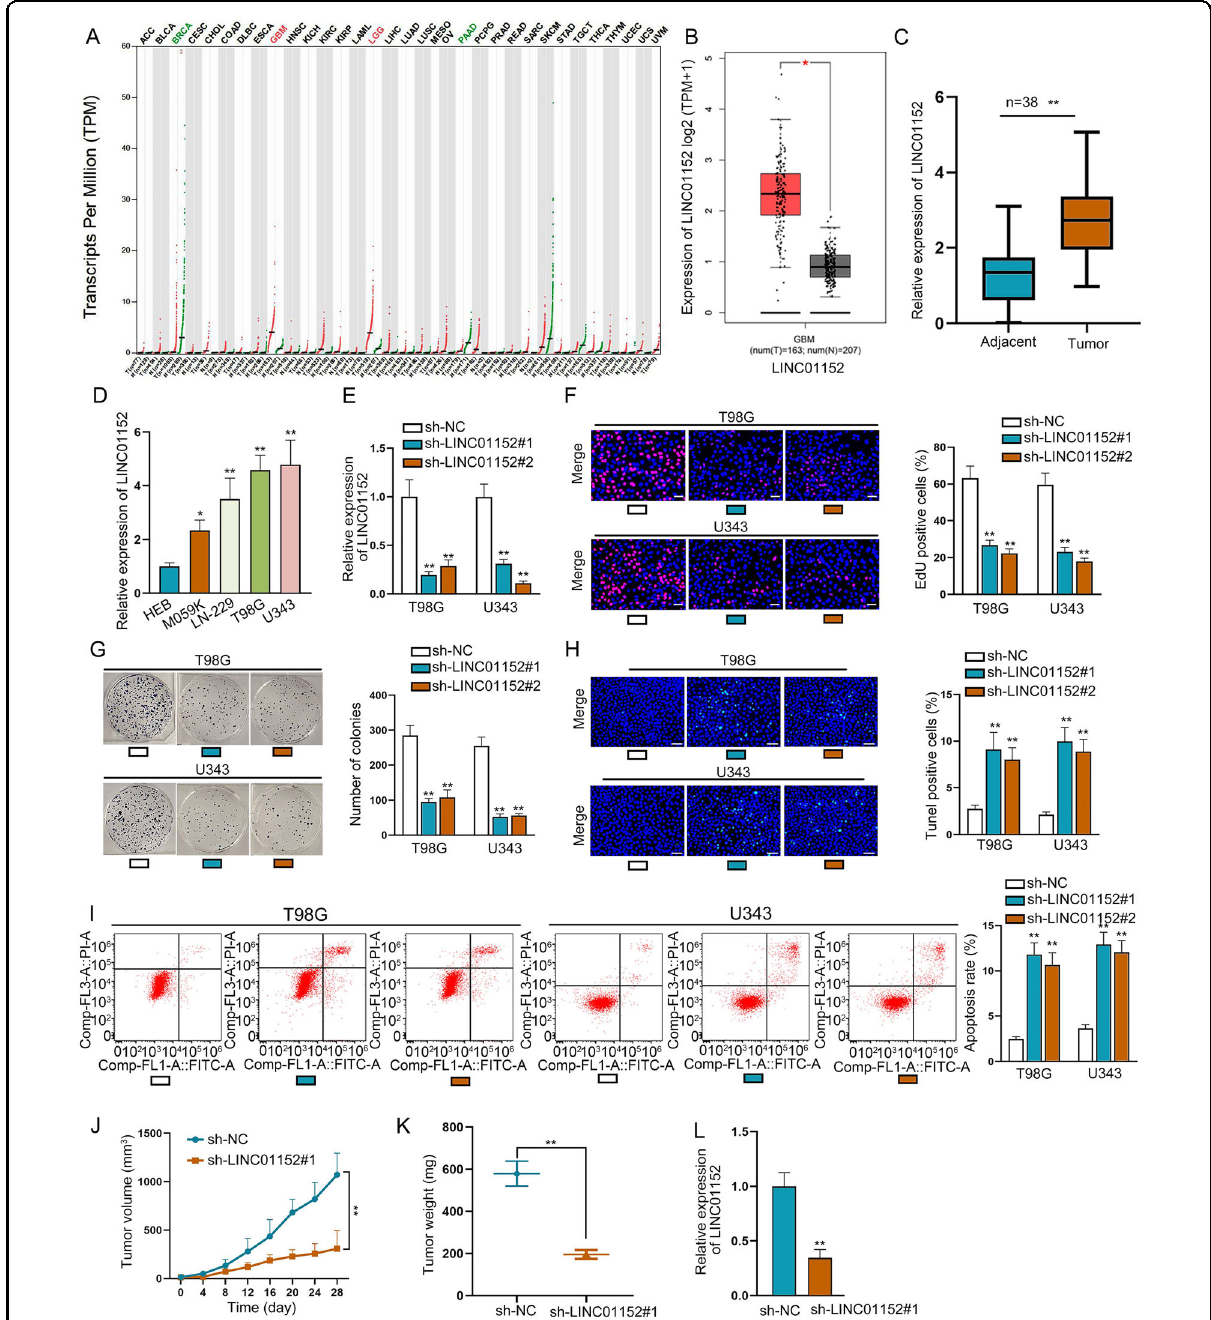
Fig. 1 LINC01152 was upregulated and played as an oncogene in GBM. A GEPIA (http://gepia.cancer-pku.cn/) database was implemented to search LINC01152 expression pattern in different cancer types including GBM. B GEPIA data of LINC01152 level in 163 GBM tissues and 207 normal brain samples. C Expression of LINC01152 in 38 pairs of GBM tissues was assessed via qRT-PCR. D qRT-PCR was conducted to determine the expression of LINC01152 in normal human glial cell line (HEB) and GBM cell lines (M059K, LN-229, T98G and U343). E Inhibition ef fi ciency of LINC01152 in T98G and U343 cells was examined via qRT-PCR. F , G EdU (scale bar = 100 μ m) assay and colony formation assay assessed the proliferation of T98G and U343 cells when LINC01152 was silenced. H , I TUNEL (scale bar = 120 μ m) assay and fl ow cytometry analysis were implemented to test the apoptosis of T98G and U343 cells when LINC01152 was silenced. J , K The volume and weight of tumors obtained from in vivo assays. L LINC01152 expression was tested in in vivo tumors from two different groups. * P < 0.05, ** P <